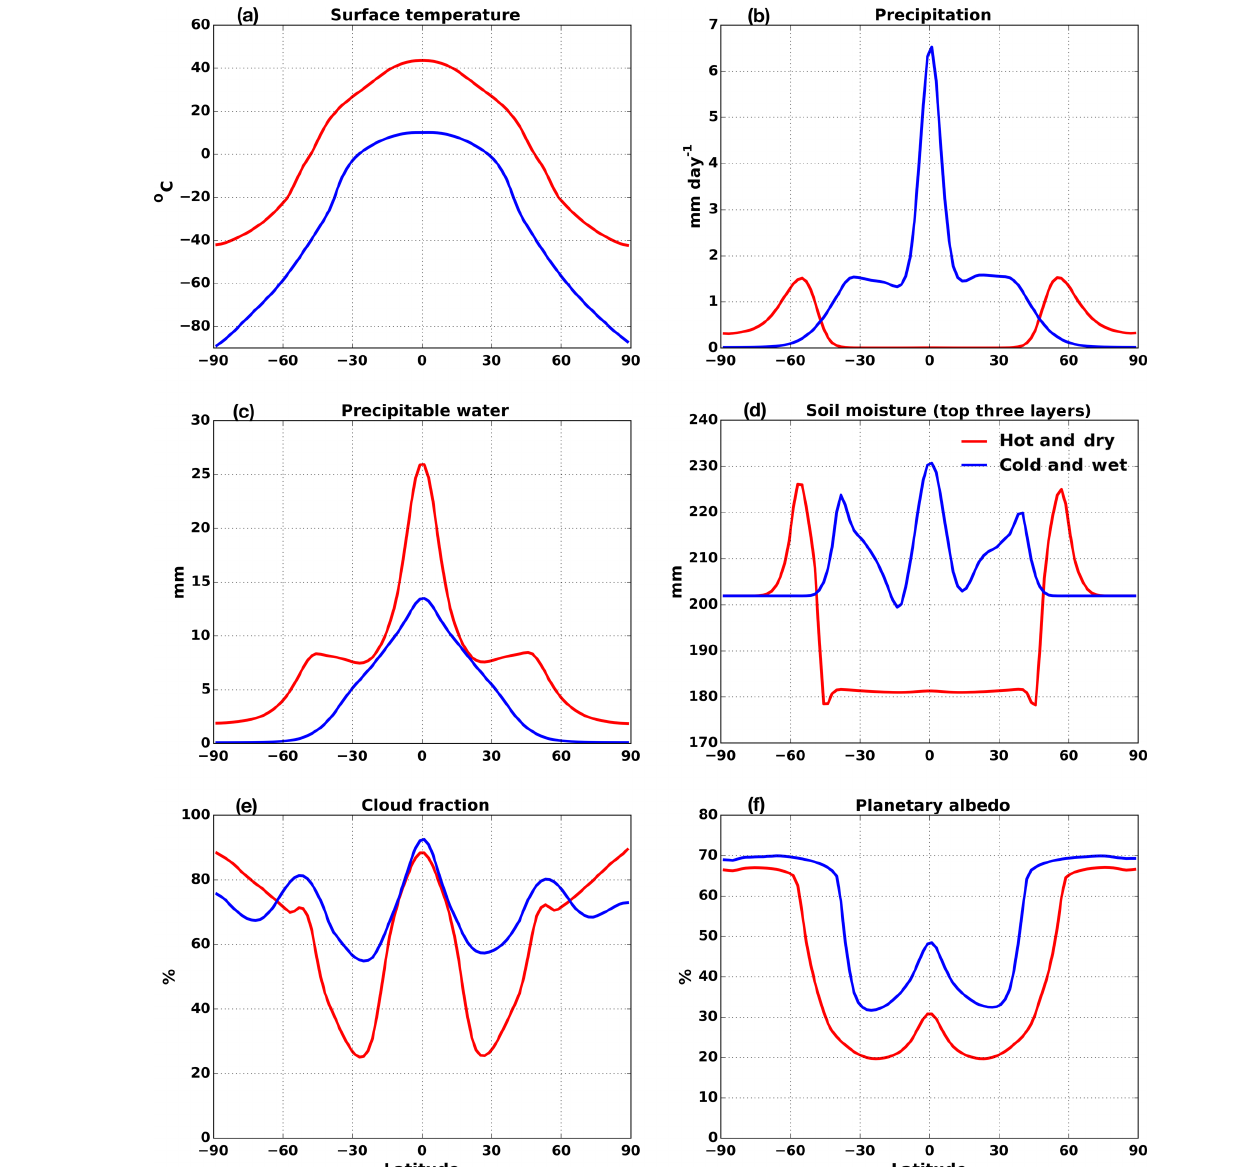
Figure B1. Annual mean meridional profiles as in Fig. 2 but with Tiedtke convection scheme plotted using T simulations in Table 1.